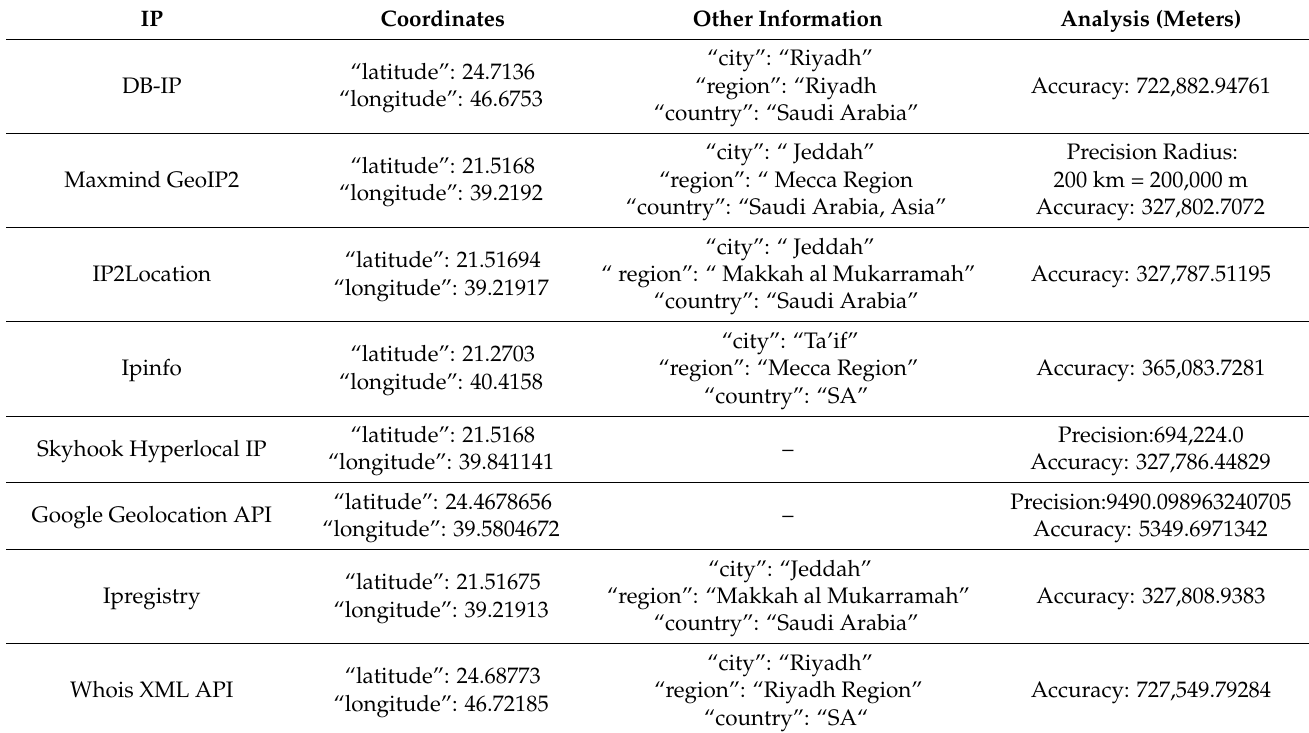
Table 11. Database-based IP geolocation by a wireless network (STC_4G).